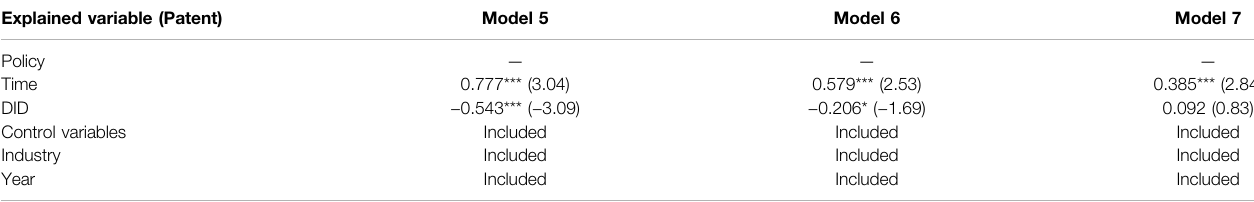
TABLE 5 | Heterogeneity analysis.